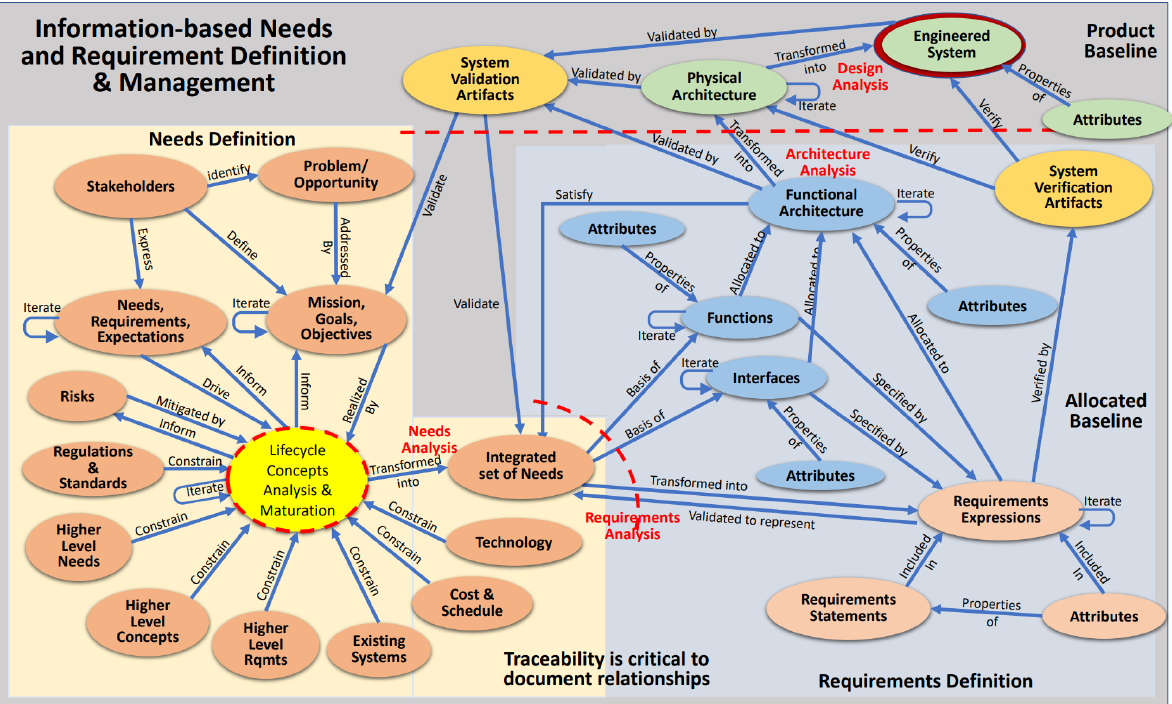
Figure 1. Information-based requirement development and management model